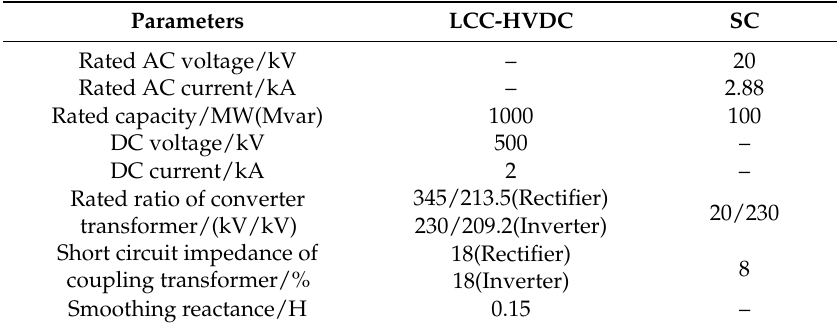
Figure 1. Schematic diagram of the LCC-HVDC system with a synchronous condenser. The main parameters of the LCC-HVDC system with a SC are summarized in Table 1. Table 1. Main parameters of LCC-HVDC with a SC.